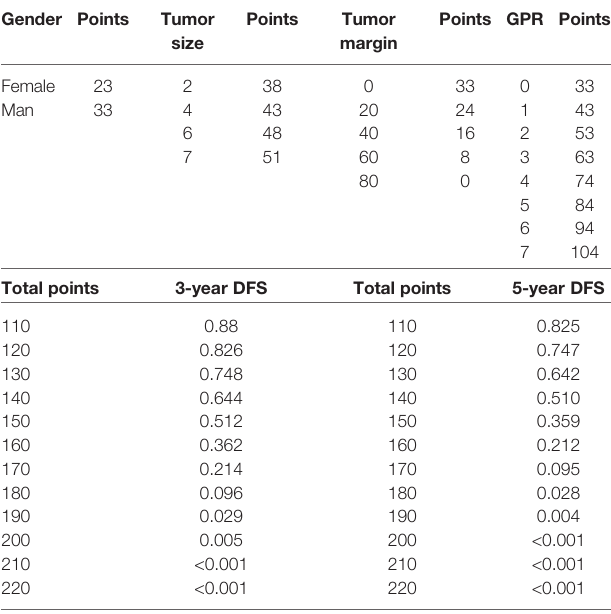
TABLE 3 | DFS nomogram scoring system.